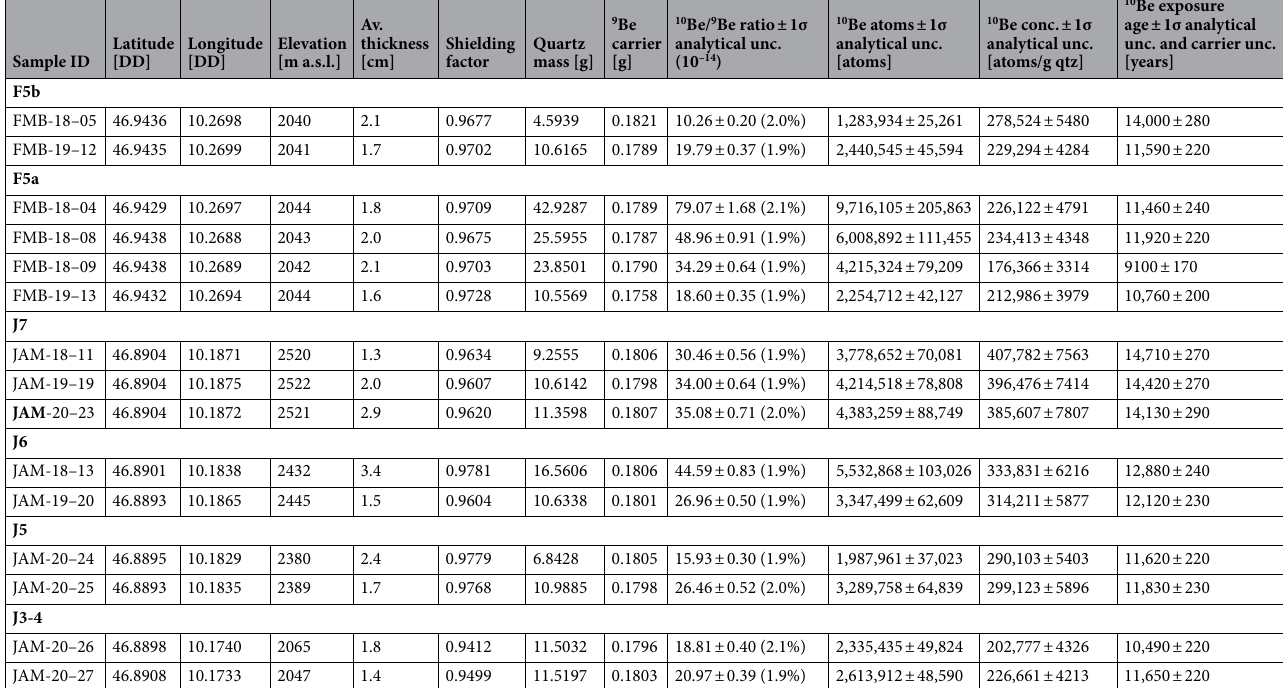
Table 1. The 10 Be analytical data and corresponding exposure ages of Jamtal and Fimbatal samples. Samples were analyzed at the CAMS–LLNL. All samples were measured against the 07KNSTD3110 standard with a ratio of 2.85 × 10 –1225 . One to two procedural blanks were processed with each batch of samples with ratios ranging from 2.3 to 8.4 × 10 –16 (Table S2). The 10 Be background contamination measured in the blanks was subtracted from the samples. Exposure ages were calculated with the calculator formerly known as CRONUS– Earth online calculator v3 26 , using the Swiss 10 Be production rate 27 and the ‘Lm’ scaling scheme. Ages are calculated relative to the sampling year denoted by the first number in the sample ID and are rounded to the nearest 10 years. Uncertainties of boulder ages include the 1σ analytical error and a 1% uncertainty on the carrier